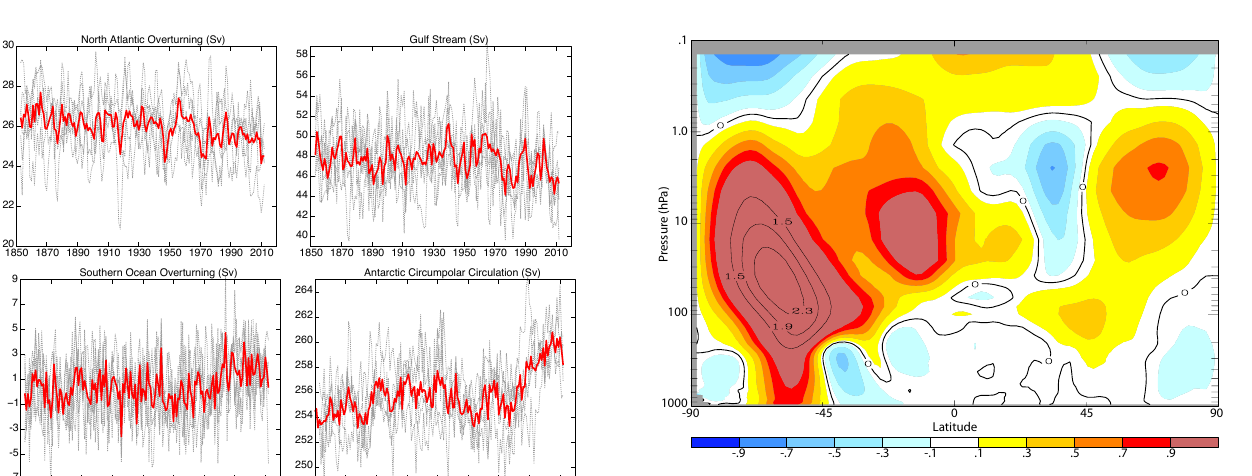
Fig. 27. Ocean and heat content trends due to ozone changes show- ing ensemble mean (red solid) and results from individual ensemble members (black dashed). The North Atlantic overturning circula- tion in the ocean is at 48 ◦ N, 900 m depth, the Gulf Stream is the maximum at 20–24 or 30–33 ◦ N, the Southern Ocean overturning is at 54 ◦ S, 3000 m depth, and the Antarctic Circumpolar Current is through the Drake Passage.